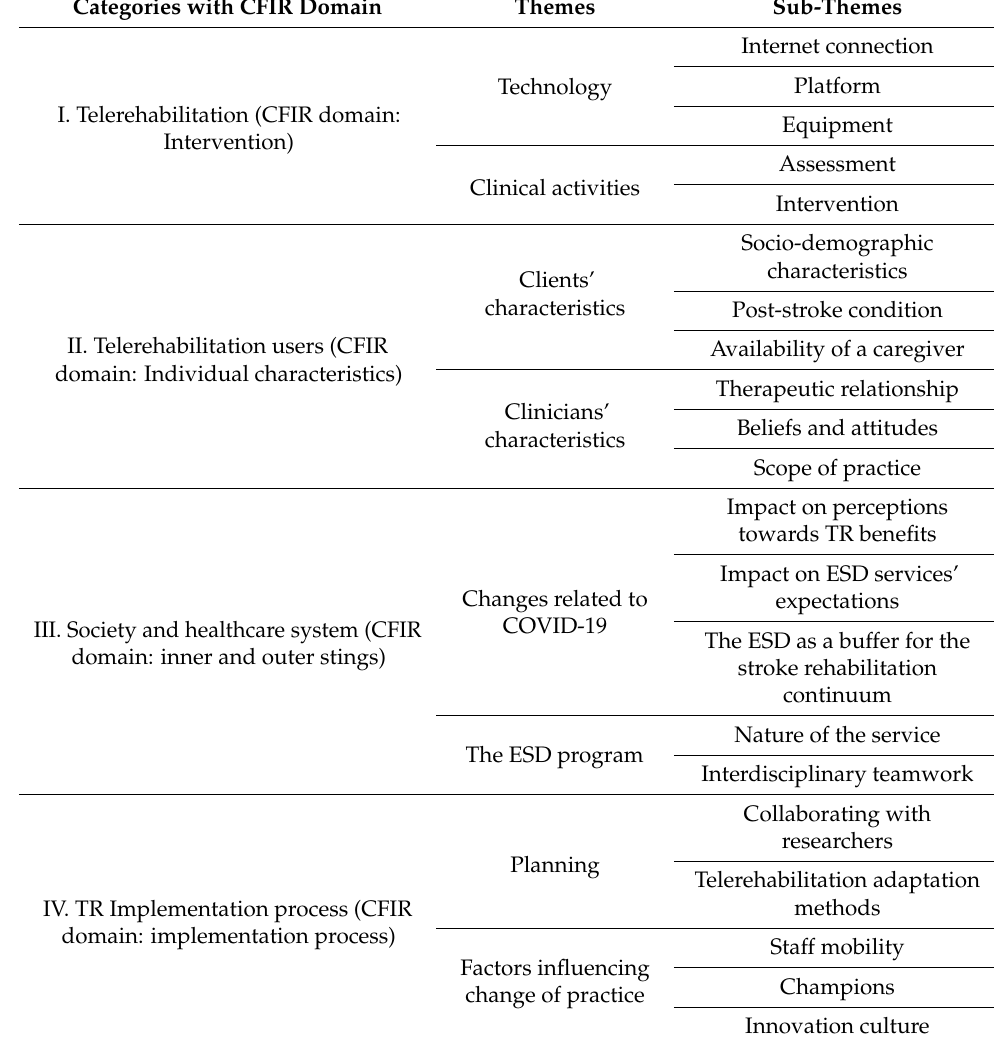
Table 3. Perceived factors influencing the implementation of TR in the ESD